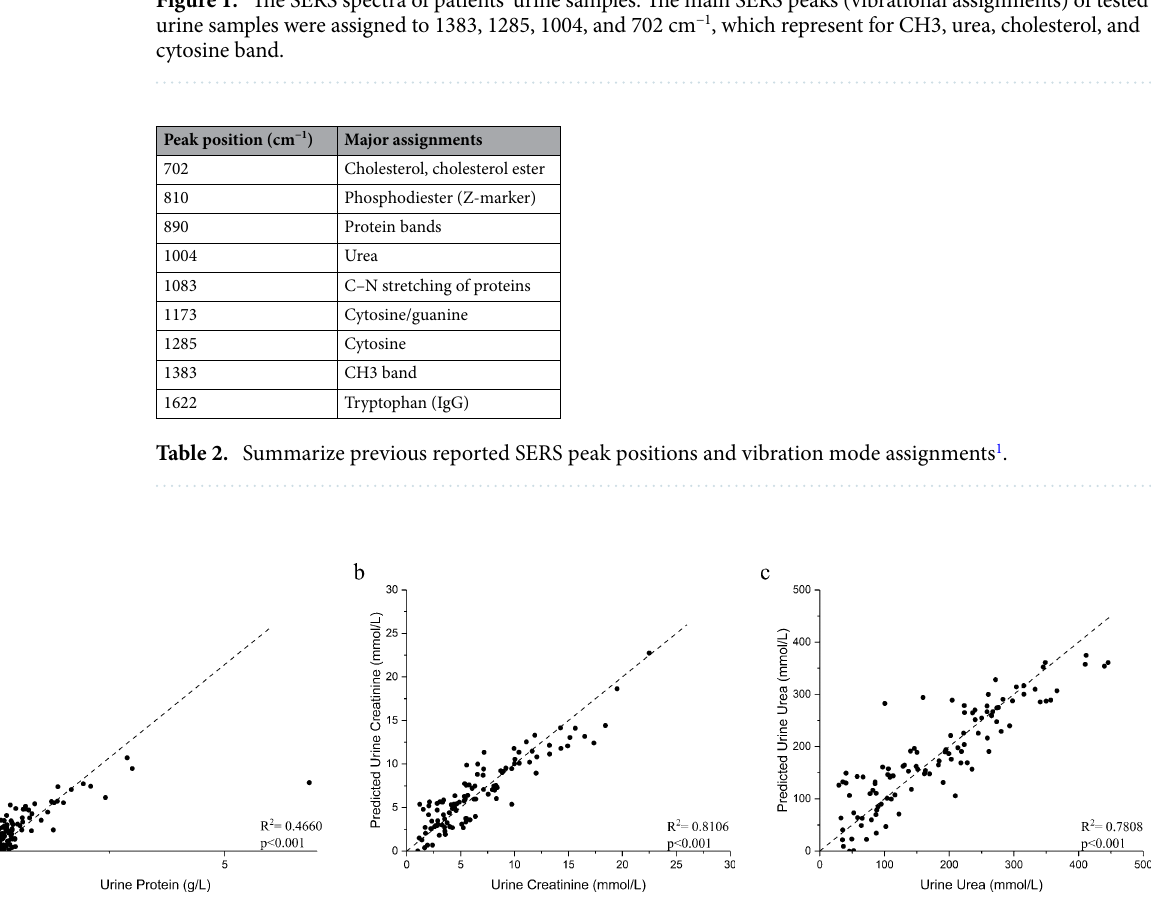
Figure 2. The PLS analysis generated models were used to predict concentrations of molecules in the urine. PLS analysis for urine protein ( a ), UCr ( b ), and urine urea ( c ). The results demonstrated that R 2 = 0.4660 for urine protein ( a ) (p < 0.001), R 2 = 0.8106 for UCr ( b ) (p < 0.001), R 2 = 0.7808 for urine urea ( c ) (p <